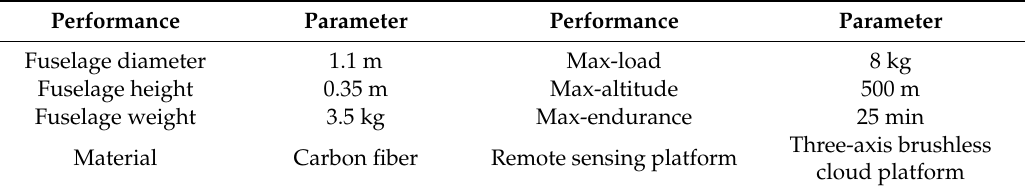
Figure 1. Sensing platform and photography equipment. ( a ) Eight-rotor UAV. ( b ) Sony A7RII full-range micro-single camera. Table 1. Parameters of eight-rotor unmanned aerial vehicle